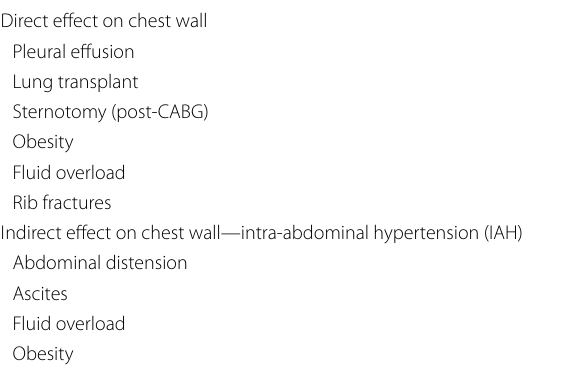
Table 1 Factors that affect “chest wall”